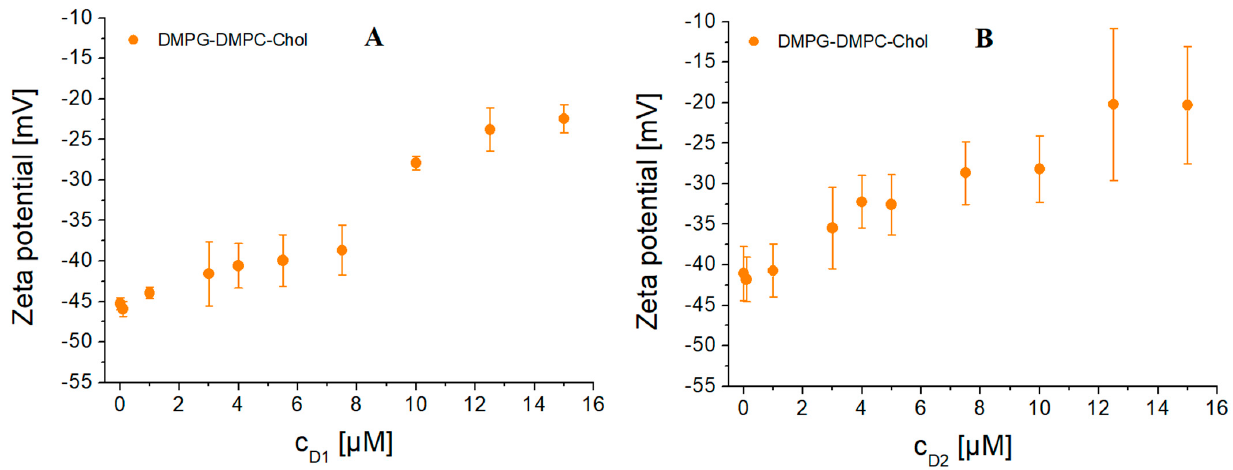
Figure A3. Zeta potential of negatively charged DMPG − DMPC − Chol liposomes upon the increasing concentration of D1 ( A ) and D2 ( B ) dendrons in Na-phosphate buffer (10 mM, pH 7.4) at 37 °C.